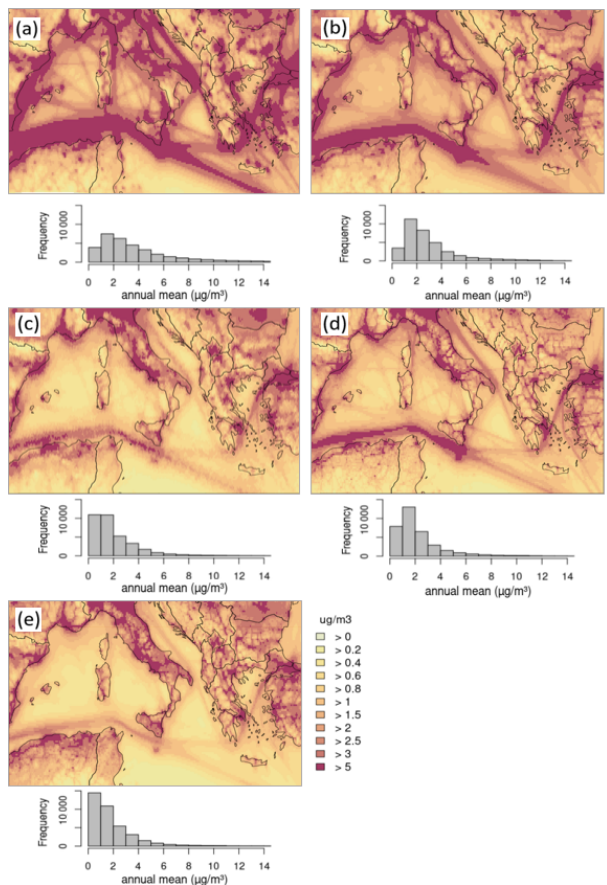
Figure 4. Annual mean NO 2 total concentration. (a) CAMx; (b) CHIMERE; (c) CMAQ; (d) EMEP; (e) LOTOS-EUROS. Be- low the domain figure the respective frequency distribution is dis- played for the annual mean NO 2 concentration, referring to the whole model